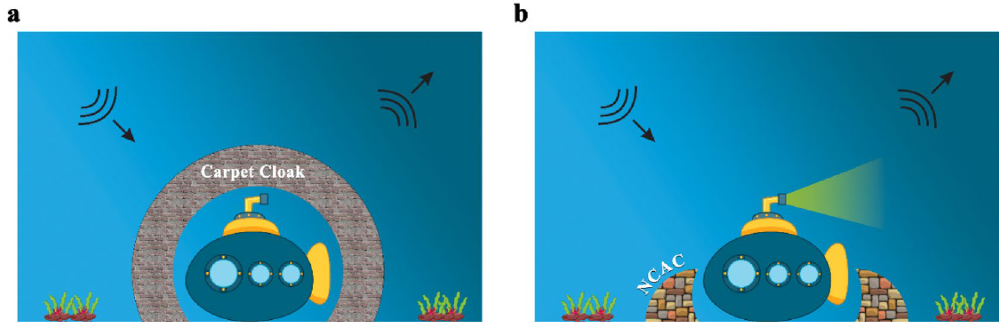
Figure 1. A schematic of ( a ) conventional carpet cloak and ( b ) NCAC for arbitrary object. The desired non- closed carpet cloak has an acoustically equal signature with its corresponding conventional one. So, the incident wave is reflected from the non-closed device as a reflecting plane, without any